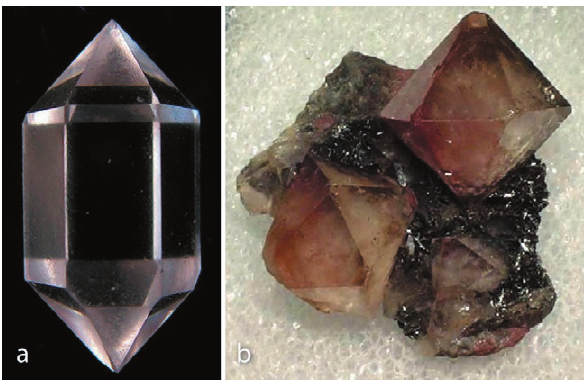
Fig. 7. Crystals of quartz. 7a: Quartz with typical habit. 7b: Quartz with “bipiramidal” habit (https://www.mindat.org/photo-188888. html; https://www.mindat.org/photo-156304.html).